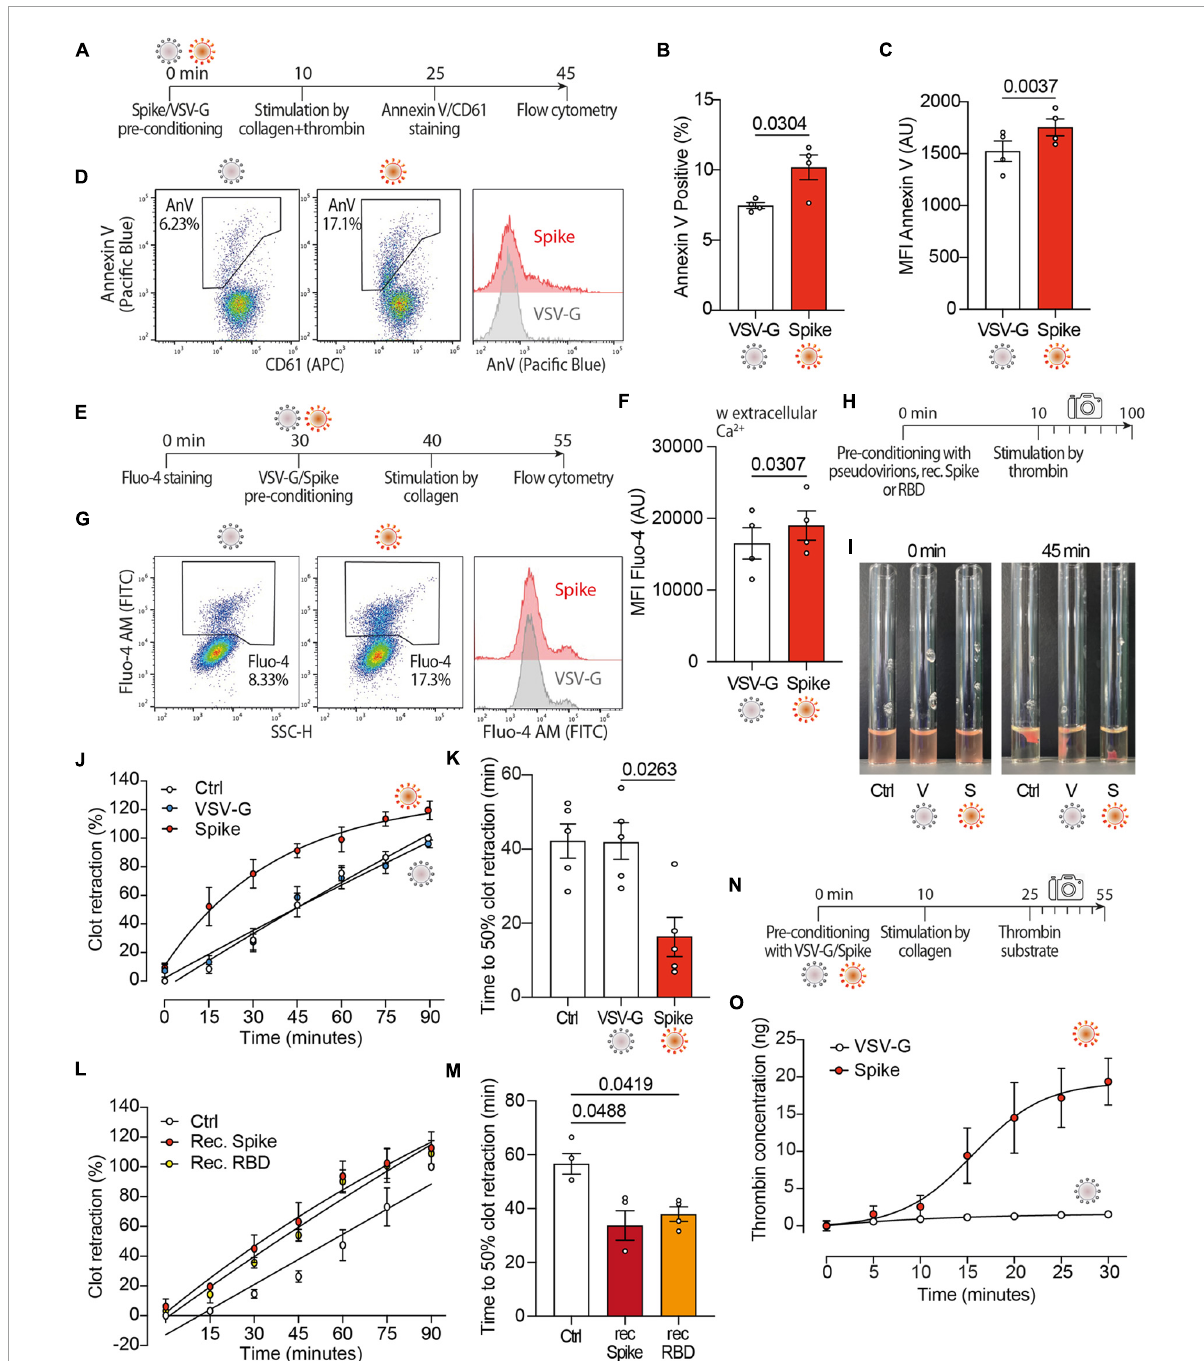
FIGURE2 Spikes activates the procoagulant activity of platelets. (A) Experimental scheme to study platelet activation by pseudovirions. Washed platelets were incubated with 1:10 diluted VSV-G or Spike for 10 min, followed by incubation with collagen (30 µ g/ml) and thrombin (0.5 units) for 15 min. Platelets were stained with Annexin V-Pacific Blue and CD61-APC for 20 min at 37 ◦ C and then analyzed by flow cytometry. (B,C) Percentage and mean fluorescence intensity (MFI) of annexin V positive platelets upon activation with Spike or VSV-G pseudovirions. Results are from n = 4 independent experiments. Data are mean ± SEM. Statistical significance is indicated (paired Student’s t -test). AU, arbitrary units. (D) Representative flow cytometry plots. The boxed area shows the percentage of platelets positive for annexin V (AnV) binding following incubation with VSV-G or Spike. The histogram on the right shows the distribution of Annexin V positive platelets after the two treatments. For each flow cytometry plot, the first gating was based on CD61/FSC to define the platelet population. Thus, the Aneexin V plot excludes